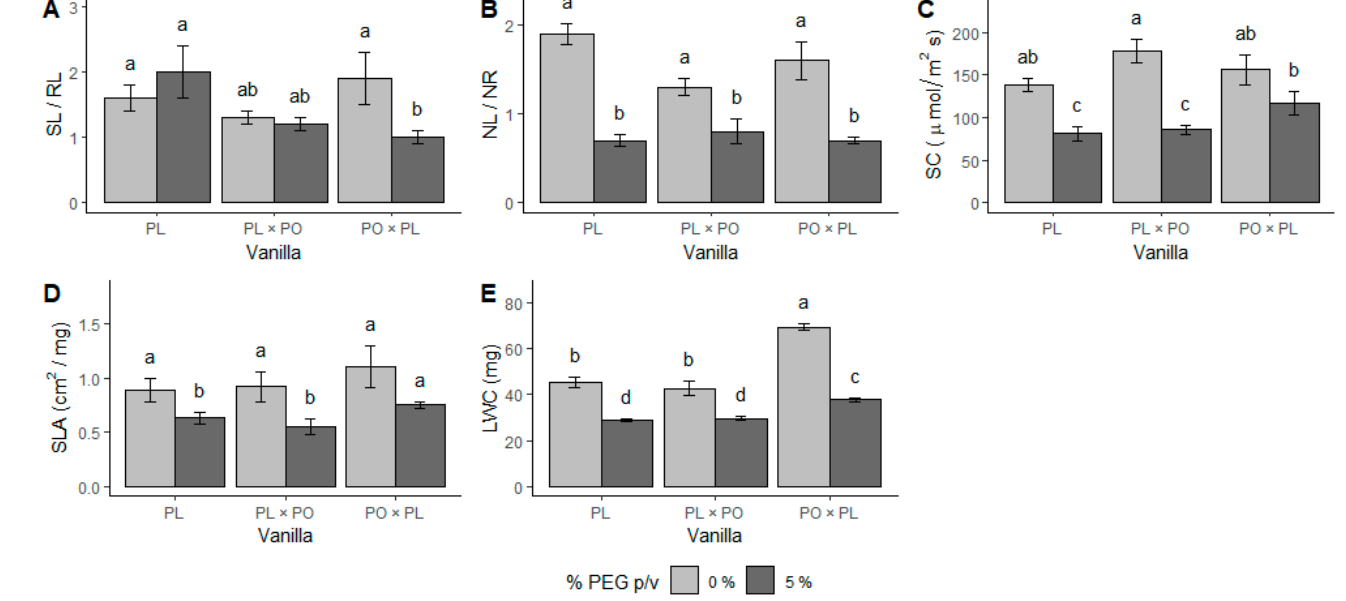
Figure 3. Water stress affects growth ratios and physiology of Vanilla planifolia (PL) seedlings and V. planifolia × V. pompona (PL × PO) and V. pompona × V. planifolia (PO × PL) hybrids. ( A ) Stem length/longest root length ratio (SL/RL); ( B ) number of leaves/number of roots ratio (NL/NR); ( C ) stomatal conductance (SC); ( D ) specific leaf area (SLA); and ( E ) leaf water content (LWC). Gray bars: 0% PEG (control group, − 0.08 mPa). Black bars: 5% PEG, hydric stress ( − 0.49 mPa). Bars with different letters are significantly different ( p < 0.05), according to GLM or ANOVA and post hoc Tukey test.